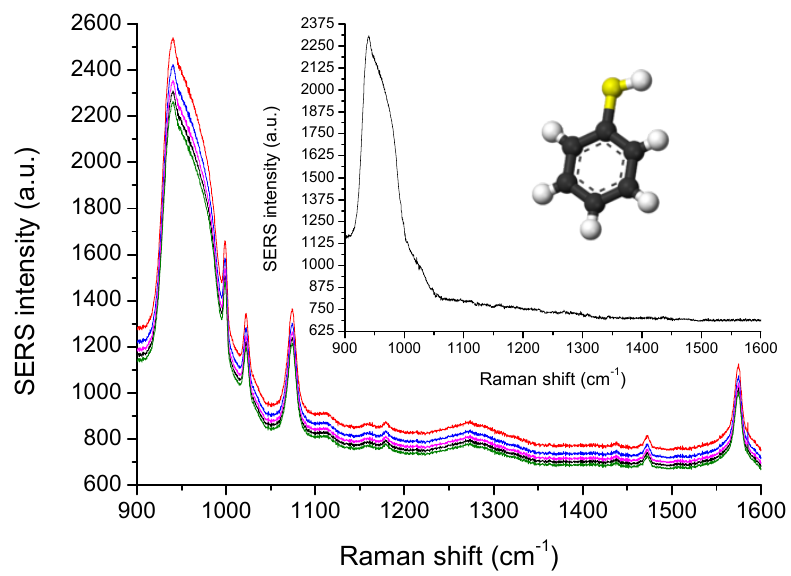
Figure 4. Five SERS spectra of thiophenol molecules recorded randomly on the whole substrate composed of Al/Si nanopillars. The inset depicts the Raman spectrum of thiophenol obtained with only Si nanopillars (without metal). Moreover, the molecular scheme of the thiophenol molecule is also displayed.